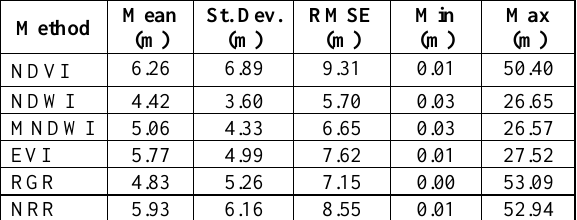
Table 5. DRI statistical values for the extracted coastlines using manually achieved coastline (based on visual interpretation of RGB composition) as